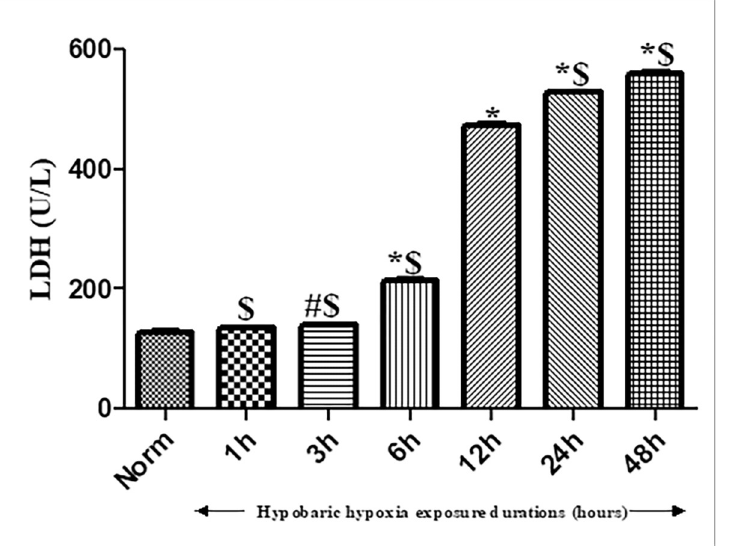
Fig 3. Effect of hypobaric hypoxia on Lactate Dehydrogenase activity (LDH) in rats exposed to hypobaric hypoxia of 7620m (25,000 ft.) at 25 ± 2˚C for different time durations (i.e.1h, 3h, 6h, 12h, 24h and 48h). Values are mean ± SD (n = 6). � p < 0.001 Norm v/s hypobaric hypoxia exposures 6h, 12h, 24h and 48h; #p < 0.01 Norm v/s hypobaric hypoxia exposure 3h. $ p < 0.001 hypobaric hypoxia exposures 12h vs 1h, 3h, 6h, 24h and 48 h. Norm- Normoxia